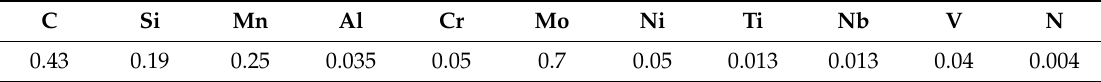
Table 1. Chemical composition of the steel (wt.%, balance